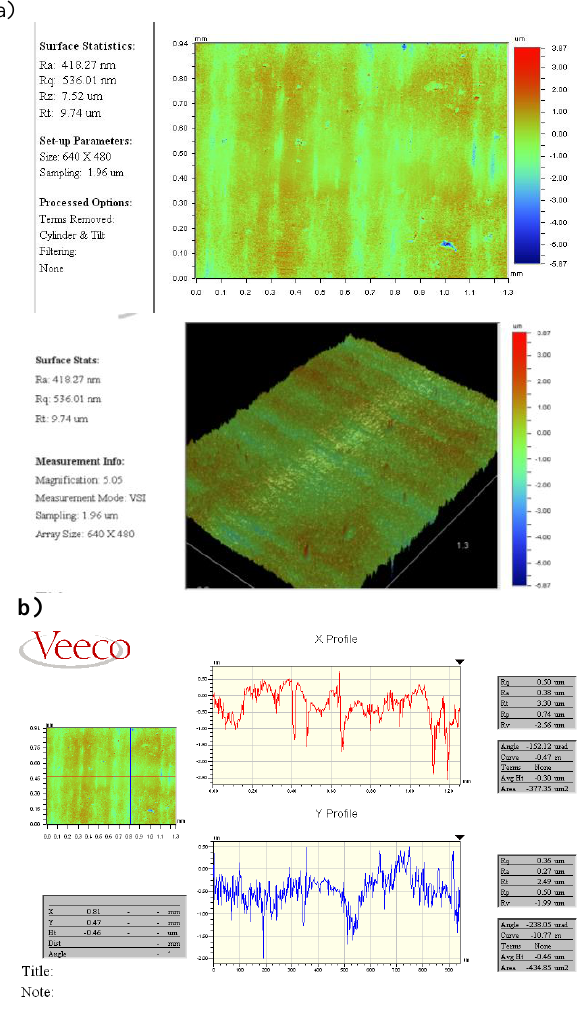
Fig. 7. Graphical results of testing the development (a) and roughness (b) of nozzle needle surface after the second test, for the first evaluated micro- area